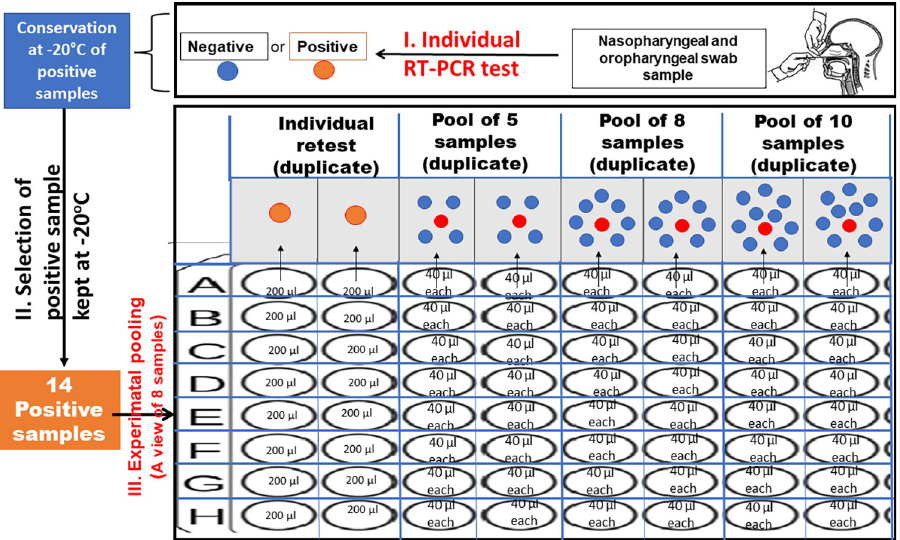
Fig 1. A display of the experimental pooling procedure in a deep-well plate. Here is a view for 8 positive samples. The rest of the 6 positive was placed in a different plate according the same organization method.